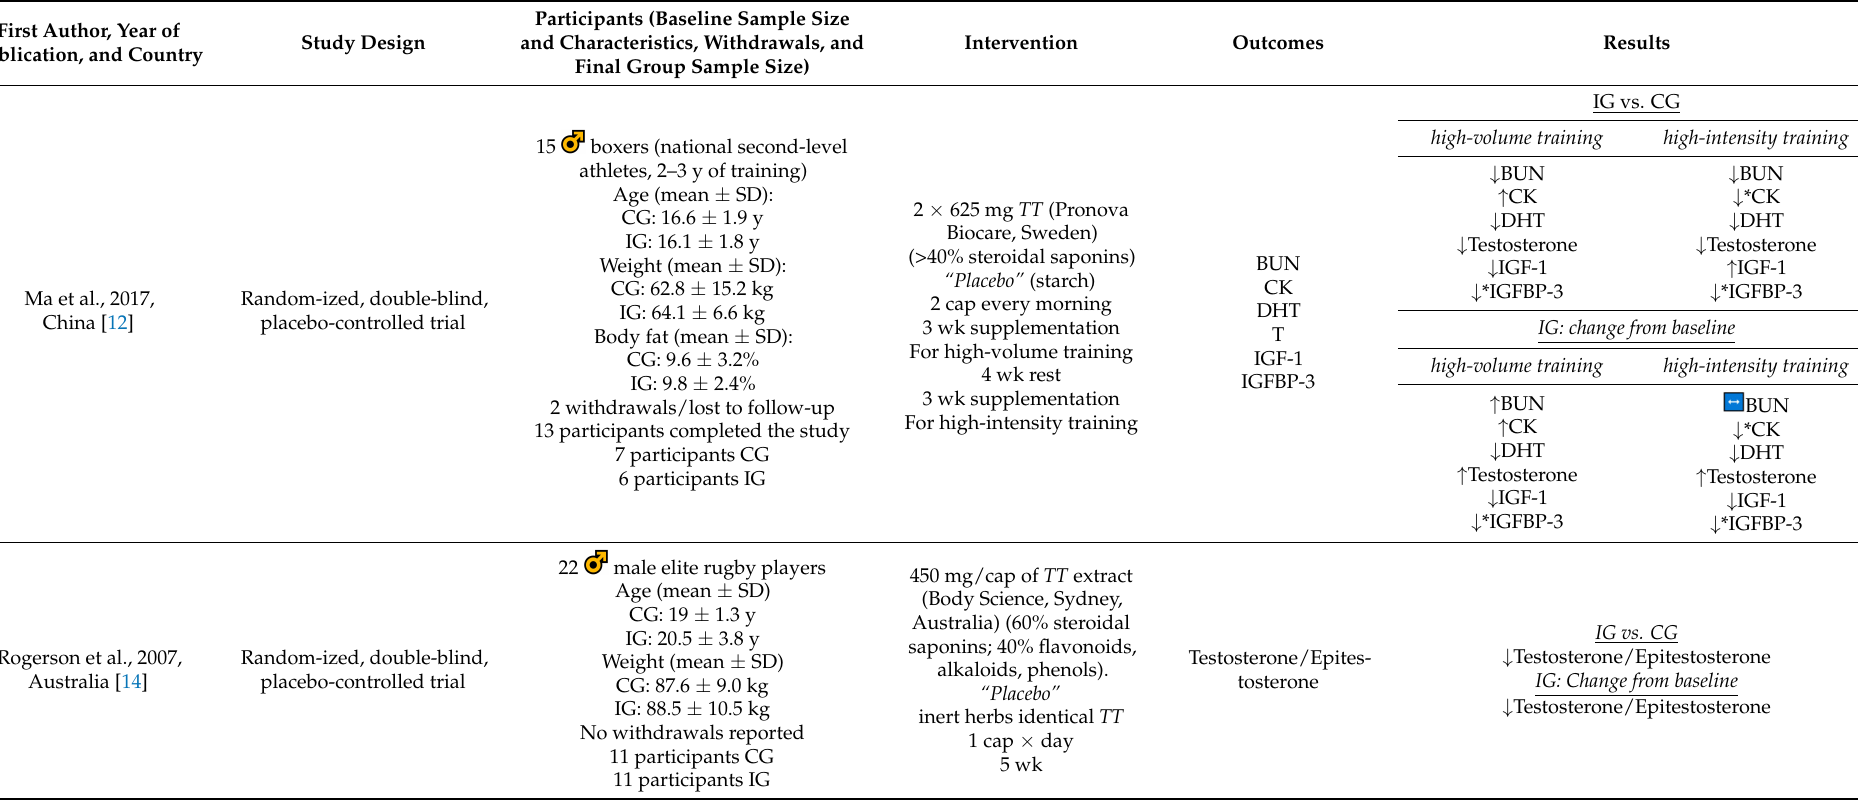
Table 3. Studies included in the systematic review of the effect of Tribulus terrestris L. on hematological and biochemical markers, hormonal behavior, and oxidant response in healthy